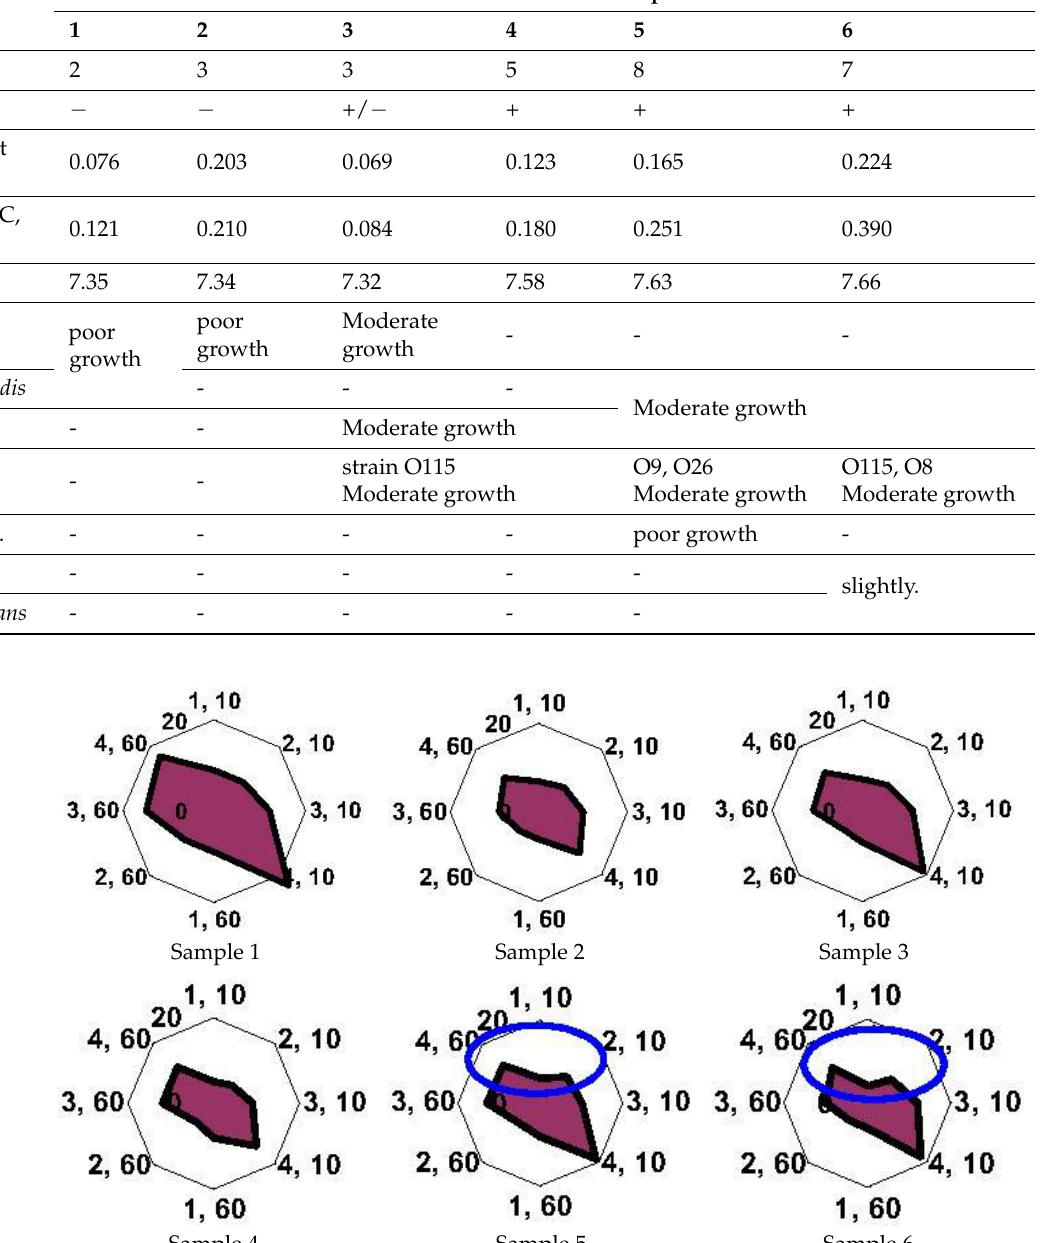
Table 14. Results of clinical examination and biochemical analysis of exhaled breath condensate samples of calves.